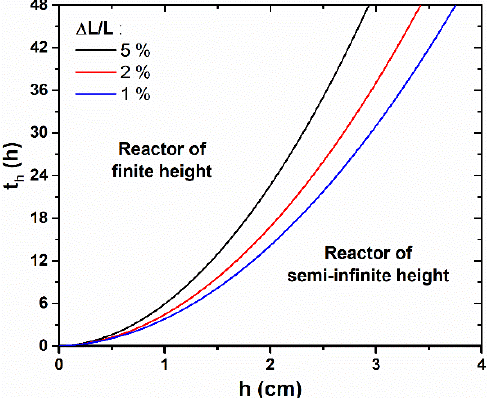
Figure 3. Theoretical evolution of the effective growth time, t h , from which the ZnO NW length, L, becomes significantly lower than the case where the reactor is of semi ‐ infinite height, i.e., when Δ L/L becomes greater than 1%, 3%, or 5%, as a function of h . If the effective growth time does not exceed t h , the problem can be simplified to the case where the reactor is of semi ‐ infinite height. The values of the different parameters correspond to a typical growth at 90 °C with 30 mM of Zn (NO 3 ) 2 and HMTA (as determined in [33]), i.e., C 0 = 19.1 mM, C eq = 15.2 mM, k 1 = 18.2 μ m/s, S = 0.3, D = 2.74 × 10 − 9 m 2 /s, and ρ = 4.20 × 10 28 m − 3 .